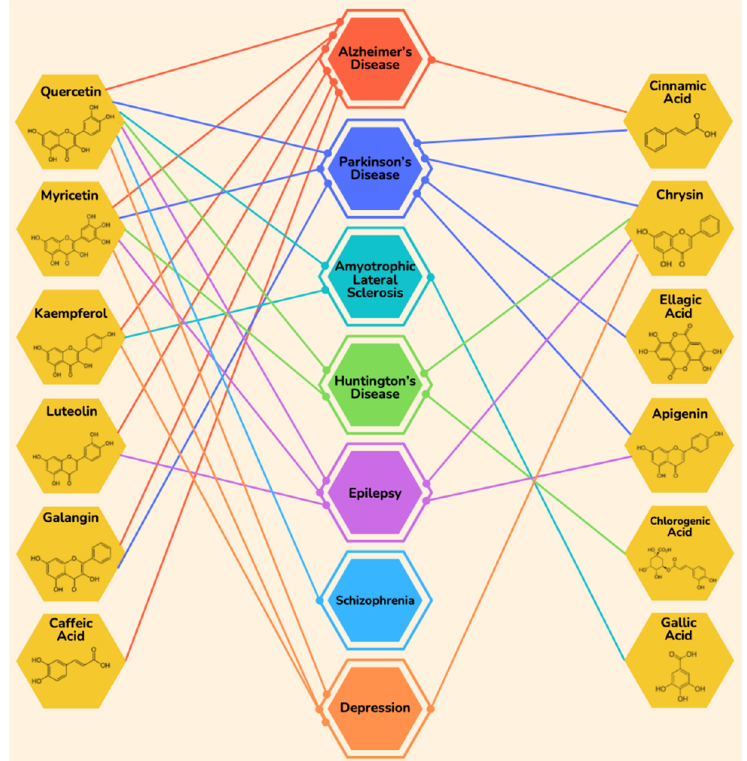
Figure 1. The therapeutic potential of various polyphenols in honey in different neurological disor- ders. Various types of honey have a wide range of these vital polyphenols, suggesting honey as a potent complementary and alternative medicine for the management and treatment of a variety of neurological diseases.